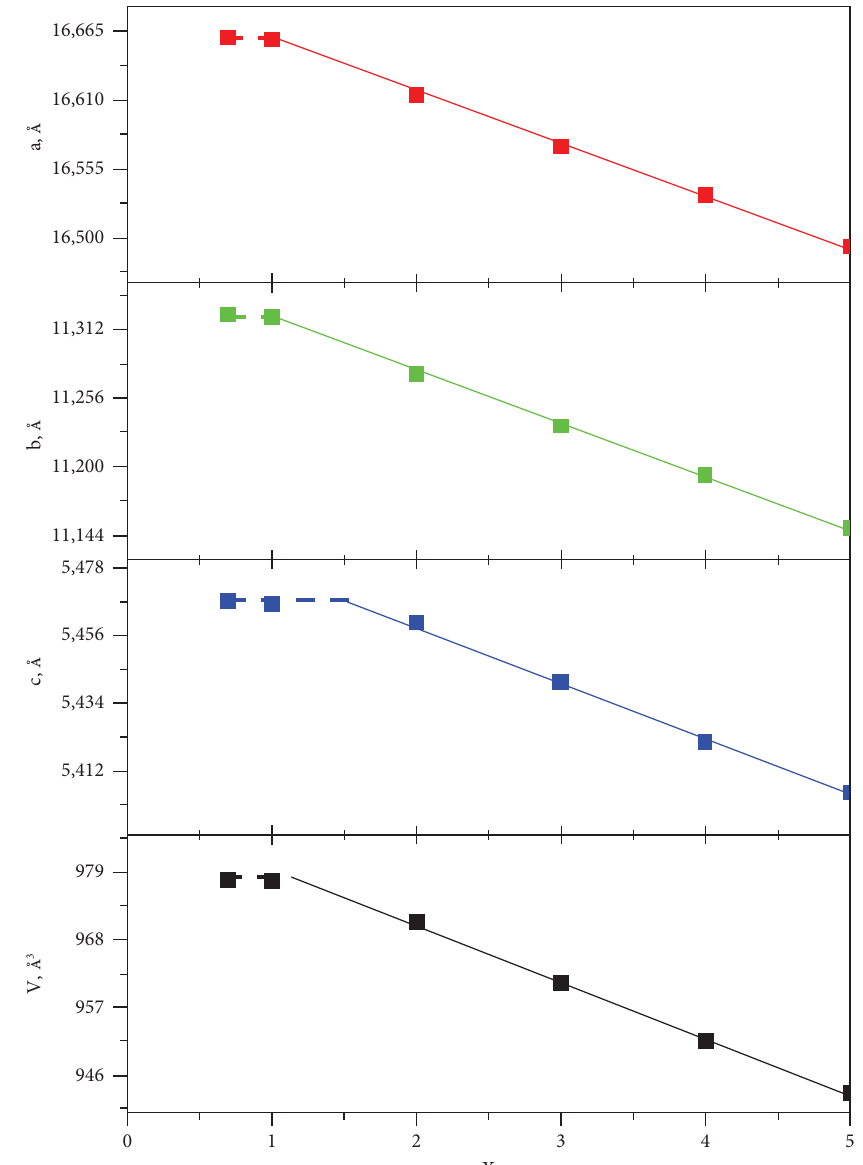
Figure 4: Unit cell parameter and cell volume variation of monoclinic phase with the Nd